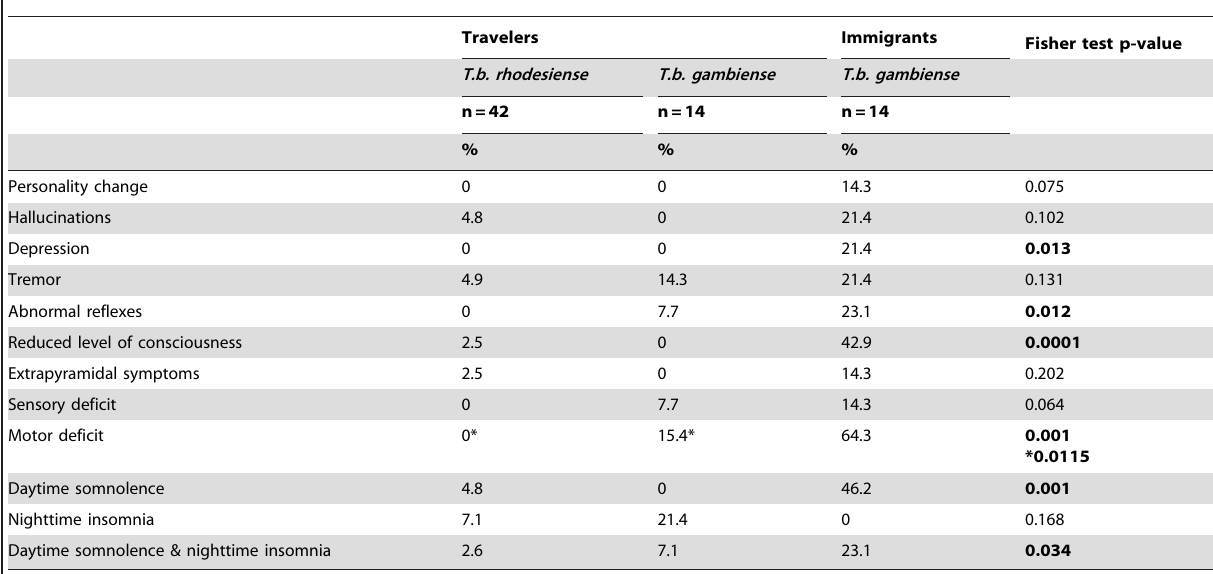
Table 3. Neurological and psychiatric symptoms.